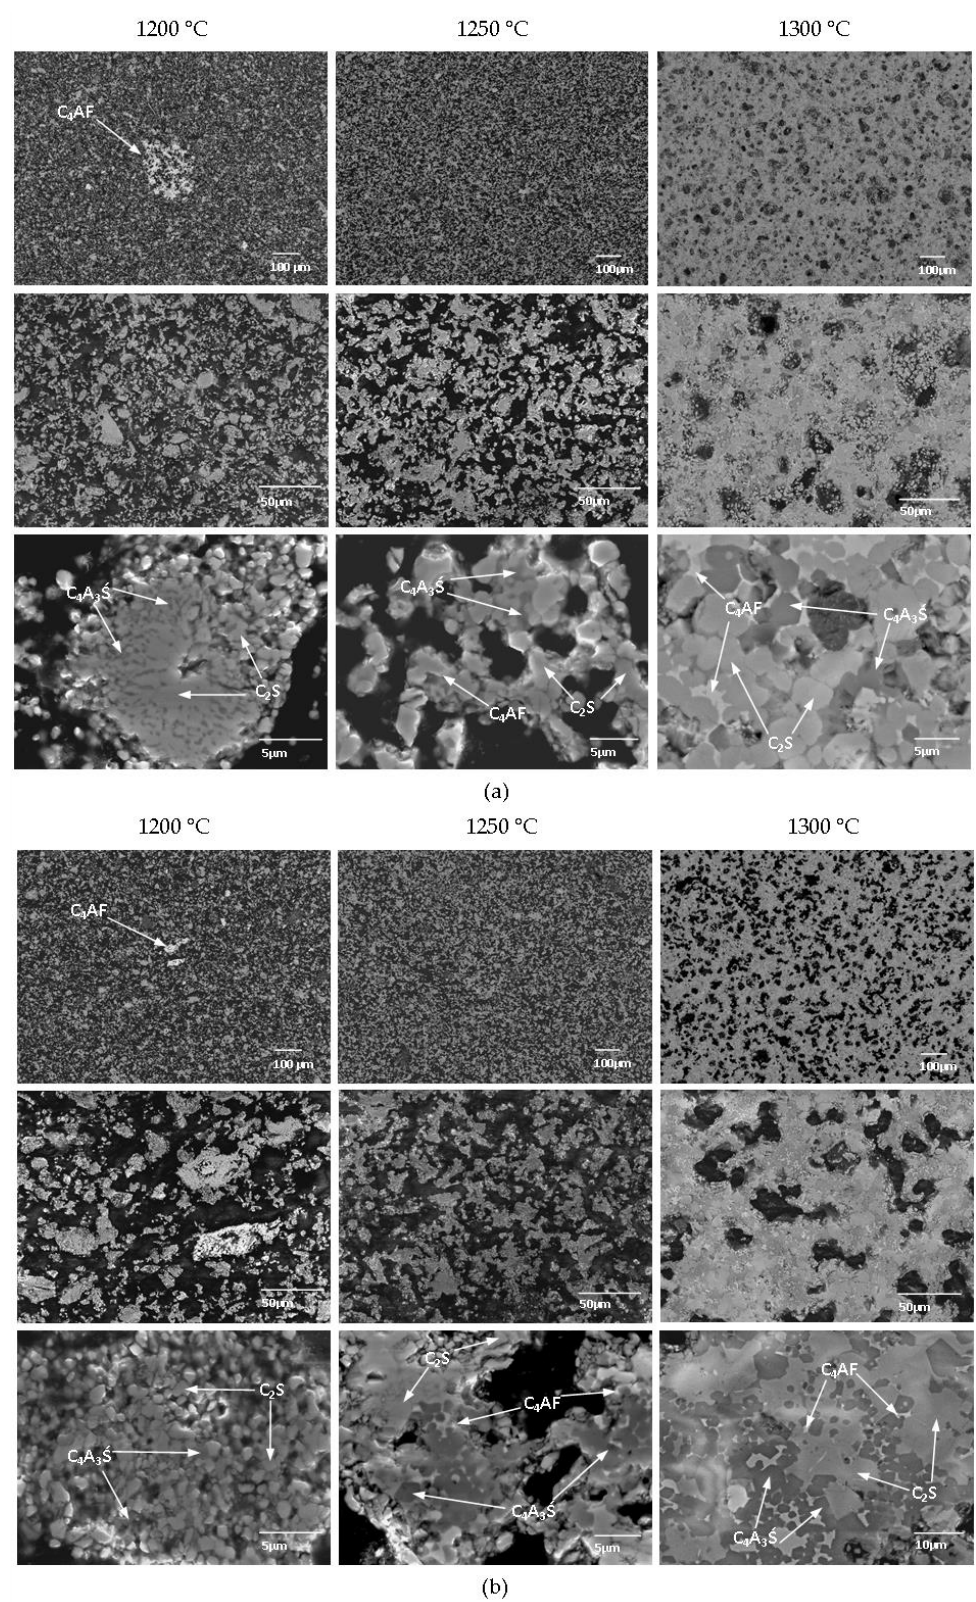
Figure 2. The phase compositions of clinkers KMO1 ( a ) and KMO2 ( b ), sintered at 1200, 1250, and 1300 °C and shown at different magnifications (Scanning Electron Microscope (SEM)/ Backscattered-Electron (BSE) microphotographs). Clinker phase designations: C 2 S = belite; C 4 A 3 Ś = calcium sulfoaluminate; and C 4 AF = ferrite.